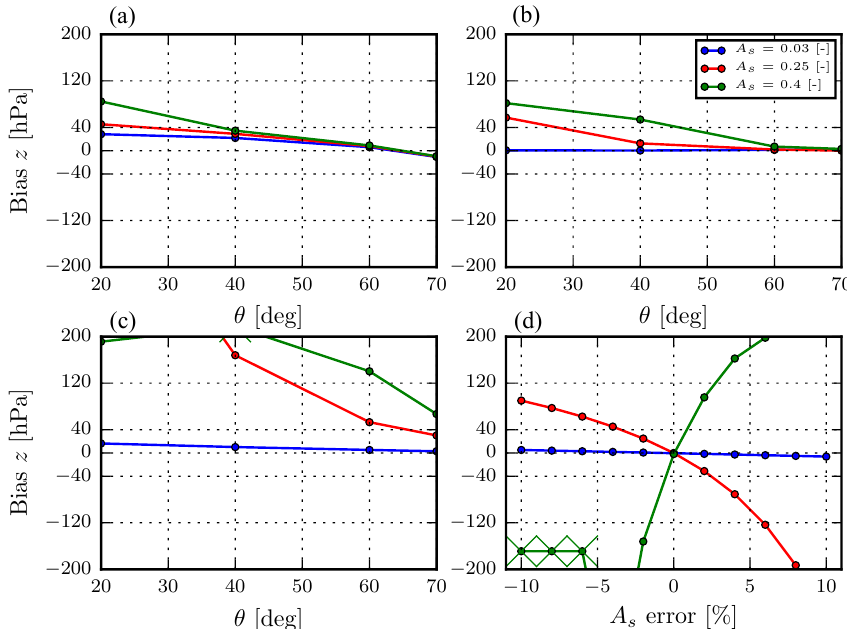
Figure 7. Bias in aerosol layer height in the presence of model errors. Unless specified, the relative azimuth angle is 0 ◦ and the solar zenith angle is 45 ◦ , aerosol single-scattering albedo is 0.95, Henyey–Greenstein g is 0.7, and there is an aerosol layer at 650hPa. (a) Model error is introduced in the thickness of the aerosol layer. The simulated spectrum contains a 200hPa thick aerosol plume extending from 1000 to 800hPa. (b) Model error is introduced in the aerosol phase function. The simulated scenes contain aerosols with scattering physics described by a Henyey–Greenstein phase function with g = 0 . 65 and retrieved with g = 0 . 7. (c) Model error is introduced in the single-scattering albedo. The simulated spectrum contains aerosols with ω = 0 . 95, which is fixed in the retrieval forward model at 0.90. (d) A relative error is introduced in the surface albedo. The viewing angle is fixed at 20 ◦